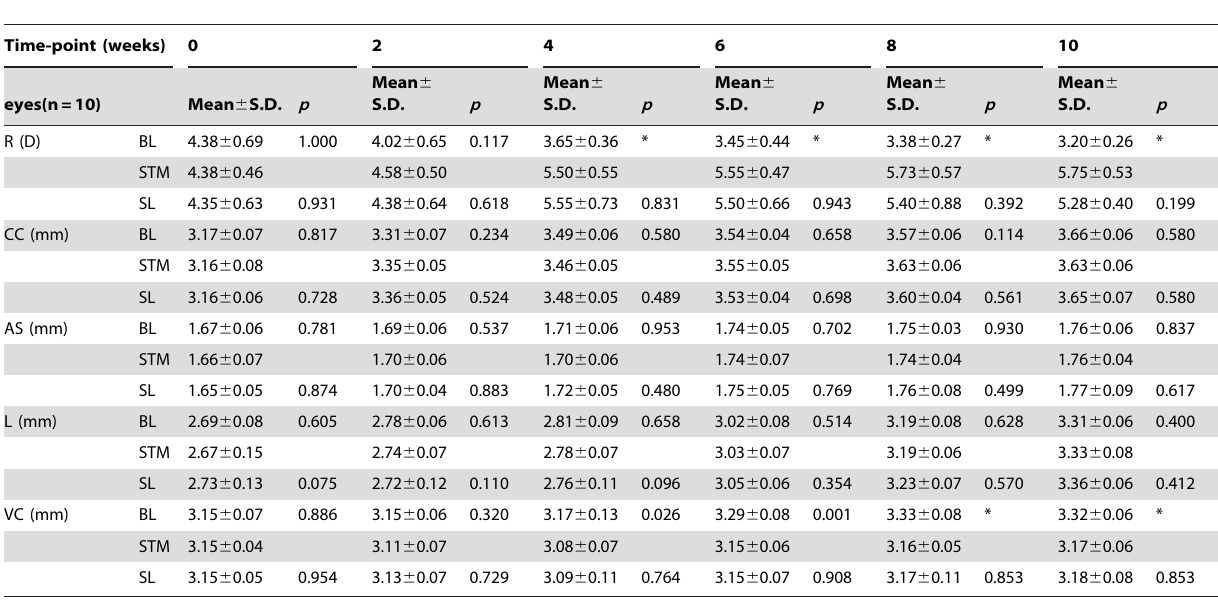
Table 2. Mean biometric results from guinea pigs reared in the three groups and the comparisons between the SL or BL and the STM groups at each time point from 0 to 10 week.